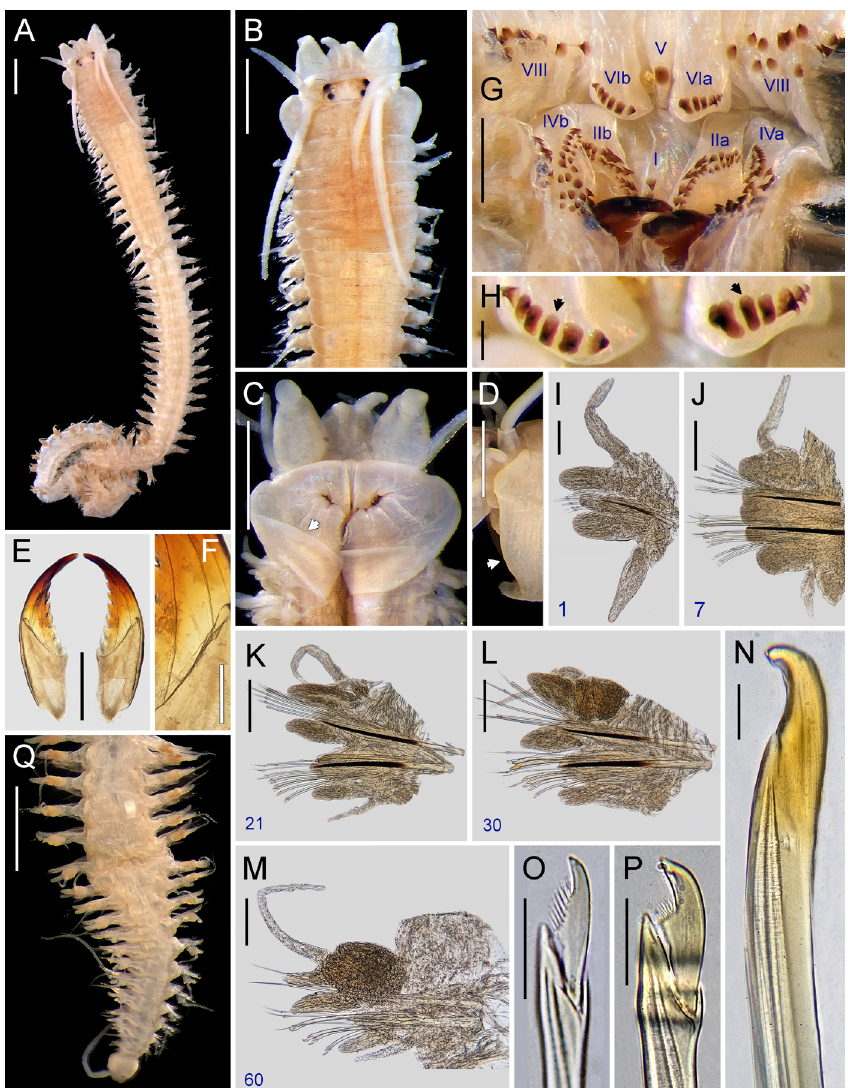
Fig. 4. Neanthes helenae Kinberg, 1865. A–C, I–P . Holotype of Nereis (Neanthes) nanciae Day, 1949 (NHMUK 1950.1.5.72-95) from Jamestown, St Helena Island, atokous. A . Entire body in dorsal view. B . Anterior end in dorsal view. C . Anterior region in ventral view, arrow indicates ventrolateral projection. I . Left parapodium from chaetiger 1 in posterior view. J . Left parapodium from chaetiger 7 in posterior view. K . Right parapodium from chaetiger 21 in anterior view. L . Left parapodium from chaetiger 30 in posterior view with ventral cirri contracted and hidden behind the neuroacicular ligule. M . Right parapodium from chaetiger 60 in anterior view. N . Heterogomph fused falciger from supracicular neurochaetae (chaetiger 30). O . Heterogomph falciger from subacicular neurochaetae (chaetiger 7). P . Heterogomph falciger from subacicular neurochaetae (chaetiger 30). — D–H, Q . Paratype of Nereis (Neanthes) nanciae Day, 1949 (NHMUK 1950.1.5.72-95) from Jamestown, St Helena Island, atokous. D . Anterior region in lateral view, arrow indicates ventrolateral projection. E . Left jaw in dorsal and ventral views, respectively. F . Inner canals of jaws in ventral view. G . Non-everted pharynx in ventral view. H . Area VI of oral ring of non-everted pharynx in ventral view, arrows indicate p-bars. Q . Posterior end in dorsal view. Roman numerals refer to the areas and Arabic numbers to chaetigers. Scale bars: A–C, Q = 1 mm; D–E, G = 0.5 mm; F, J–L = 0.2 mm; H–I, M = 0.1 mm; N–P = 20